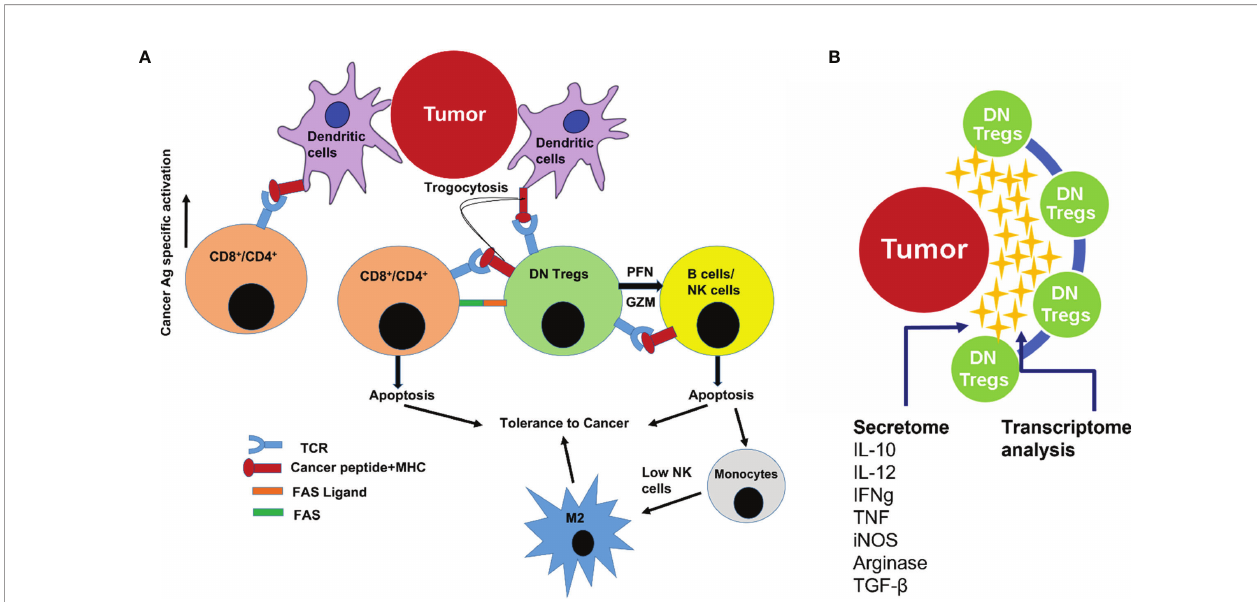
FIGURE 6 | (A) Cartoon illustration showing how DN T cells regulate the proliferation and effector T-cell function in the tumor microenvironment. DN T cells cause peripheral deletion of activated T cells through repeated T Cell Receptor (TCR) stimulation (by exhaustion). DN T cells also induce apoptosis of B cells and Natural Killer (NK) cells (by granzyme and perforin cytotoxicity). Absence of, or a low count of, active NK cells leads to macrophage plasticity activation that allows macrophage subtype M0 to differentiate to M2 phenotype (precancerous/cancerous-associated phenotype). (B) Cartoon illustration showing that the interplay between DN T cells in the tumor microenvironment was mediated also through several secretory cytokines and chemokines (secretome), allowing for the use of transcriptome analysis to pinpoint the onset/progression of thyroid